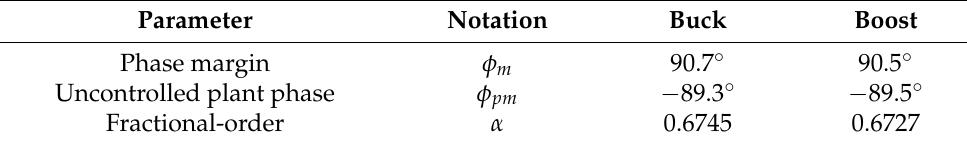
Table 2. Values of φ m , φ pm and α for buck/boost conversion